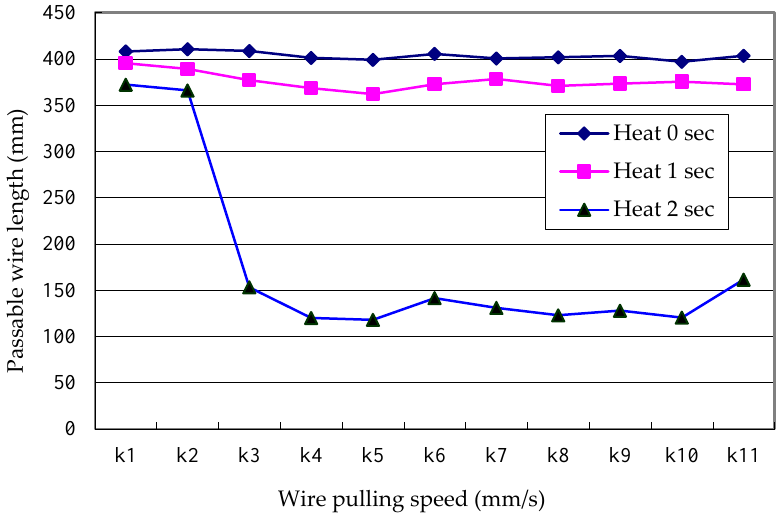
Figure 8. Passable wire length vs. wire pulling speed for the 0.6 mm wire at different heating periods.